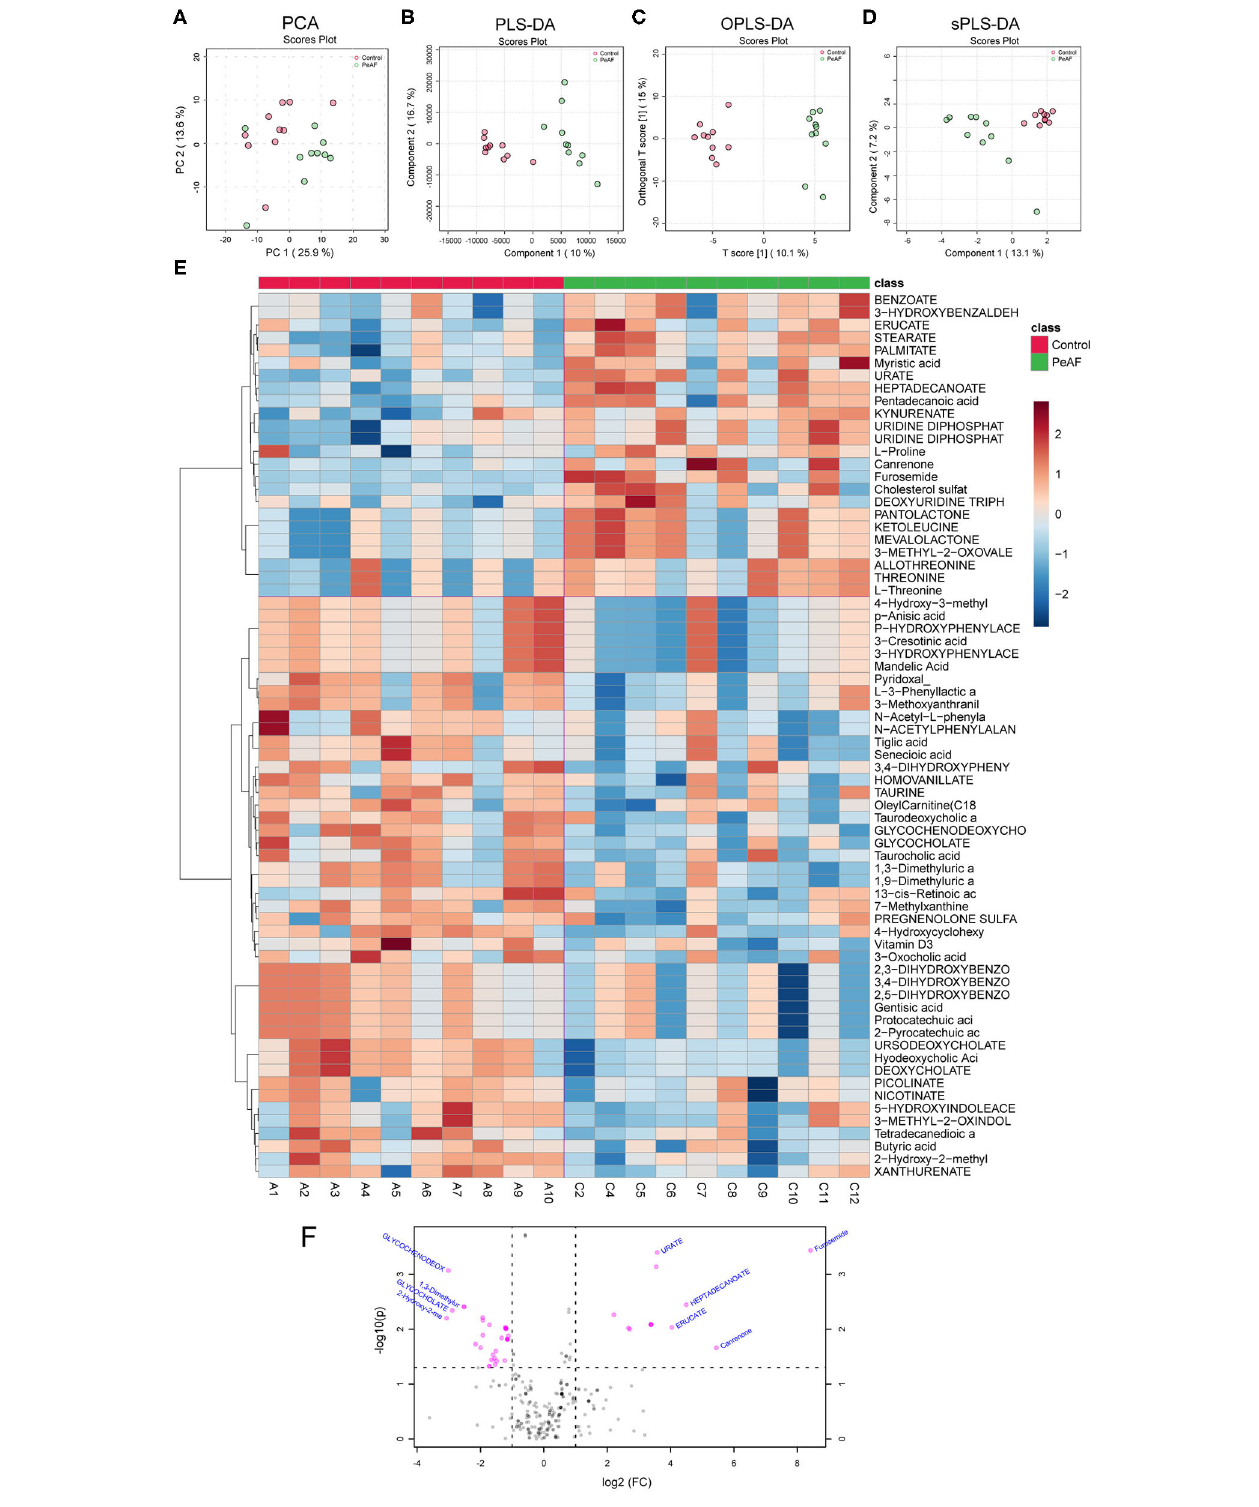
FIGURE 6 | Differences in metabolites produced by the intestinal flora. (A) Principal component analysis (PCA). (B) Partial least squares discriminant analysis (PLS-DA). (C) Orthogonal partial least squares discriminant analysis (OPLS-DA). (D) Sparse partial least squares-discriminant analysis (SPLS-DA). (E) Cluster analysis of 70 different types of metabolites. (F) Volcanic plot of differential metabolites (|log2(FC)|>1, PeAF/control).